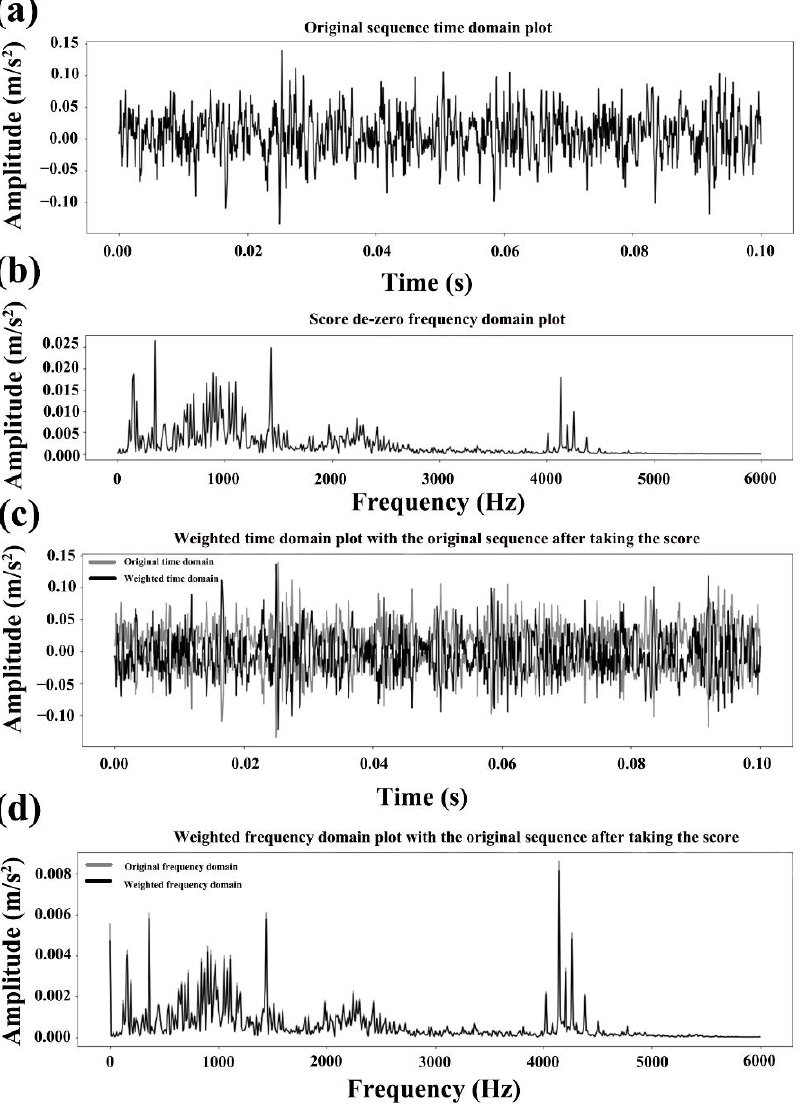
Figure 12. ( a ) Original sequence time-domain plot; ( b ) frequency-domain plot; ( c ) Weighted frequency domain plot with the original sequence after taking the score; ( d ) Weighted frequency domain plot with the original sequence after taking the score. Table 4. Accuracy of STAT and MTAT under different sample